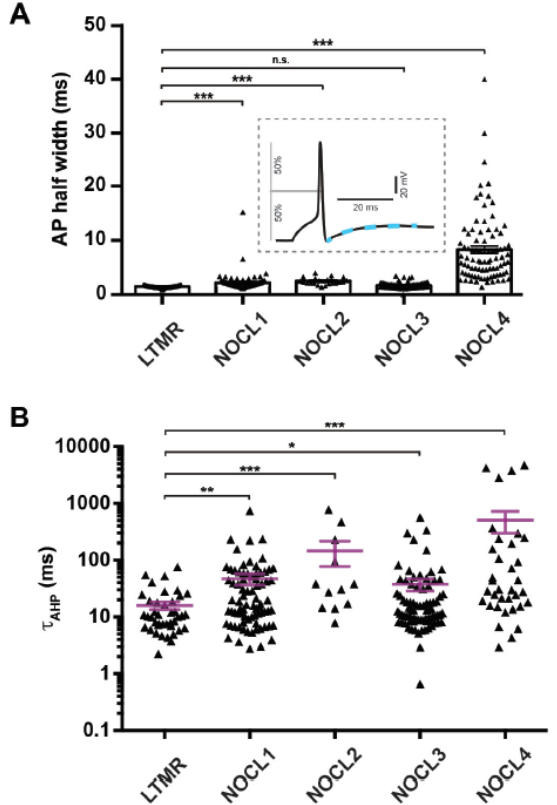
Figure 6. ( A ) Somatic action potential (AP) half-width determined as indicated in the example shown in the inset; LTMR ( n = 43), NOCL1 ( n = 109), NOCL2 ( n = 70), NOCL3 ( n = 90) and NOCL4 ( n = 87) were compared by Mann–Whitney test, n.s. ( p = 0.1243), ** ( p = 0.0023), *** ( p < 0.0001). ( B ) Recovery from after-hyperpolarization was fitted with a single exponential function (blue dashed line in ( A )). n.s. ( p = 0.1522), * ( p = 0.0337), ** ( p = 0.0020), *** ( p ≤ 0.0003), Mann–Whitney test. In ( A ) and ( B ) each triangle in the scatter plots corresponds to one cell, mean ± SEM is